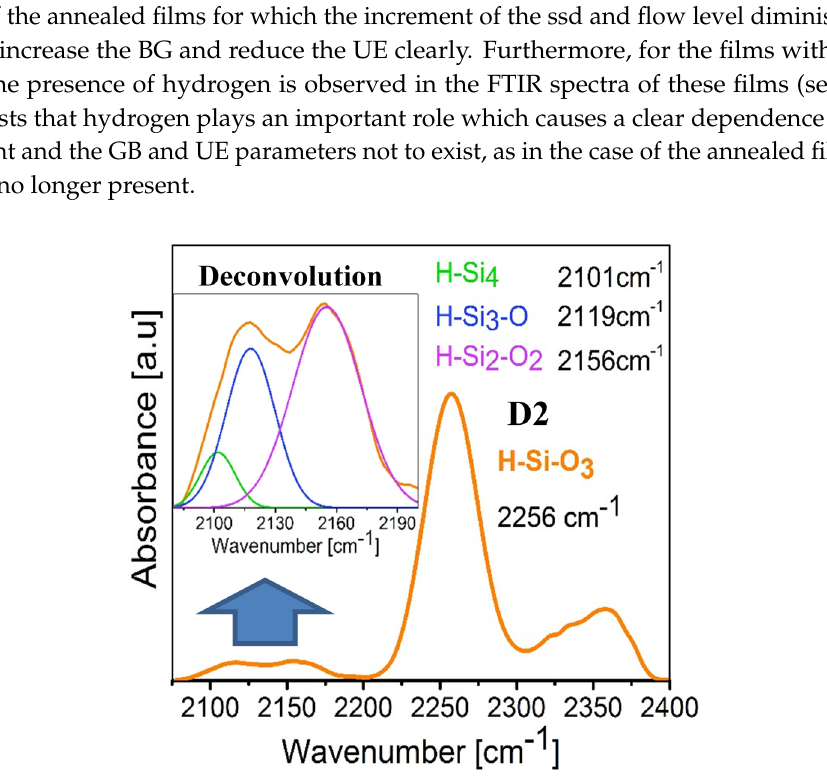
Figure 12. FTIR spectrum of the D2 film showing the absorption peaks attributed to the different configurations of the Si-H bonds. Table 7. Si–H stretching vibration bands.